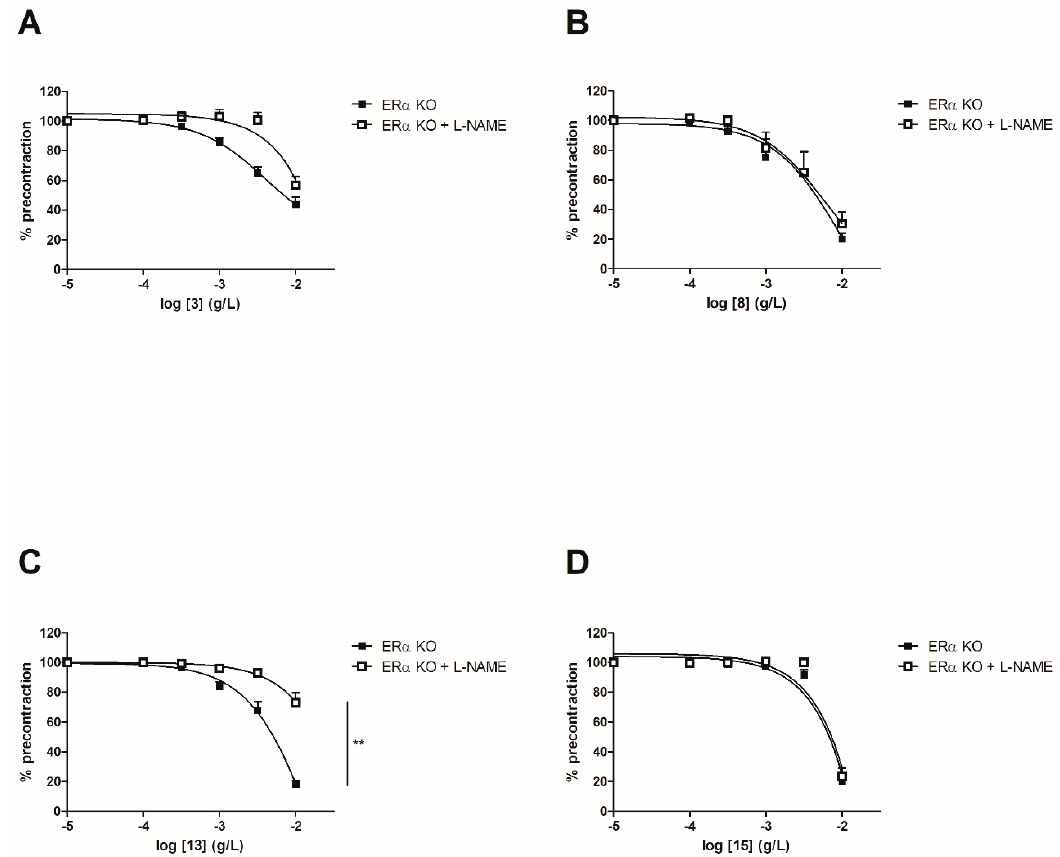
Figure 5. Concentration-response curves for the vasorelaxation effect on ER α KO mice thoracic aorta of synthetic chalcones 3 ( A ), 8 ( B ), 13 ( C ) and 15 ( D ). Mice were ovariectomized 7 days before the experiment. Vessels were pre-contracted with U46619, phenylephrine, and serotonin, at 80 % of their maximal response. The presence of functional endothelium was assessed by determining the ability of acetylcholine (10 µ M) to induce more than 50% relaxation of pre-contracted rings. Results are expressed in percentage of precontraction ( y -axis) following the concentration ( x -axis). L-NAME only prevented the chalcone 13 -induced vasorelaxation (81.96 ± 2.46% vs 26.96 ± 6.72%) while having no effect with synthetic chalcones 3 , 8 and 15 . N = 4–7, ** p < 0.01 (Mann-Whitney).